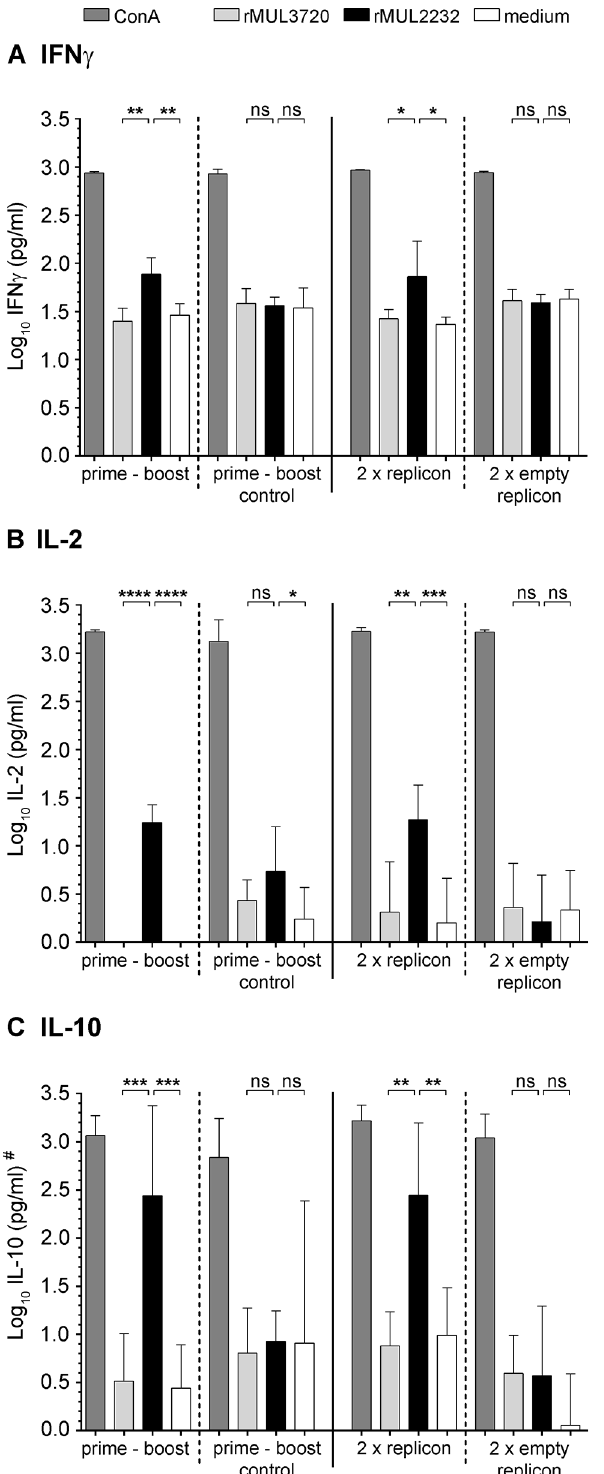
Fig 4. Analysis of cellular immune responses. Female BALB/c mice (n = 5) were immunized once with VSV * Δ G(MUL2232) (i.m.) and boosted with rMUL2232 (s.c., prime-boost) or were immunized with VSV * Δ G (i.m.) and boosted with rMUL2232 (s.c., prime-boost control). Alternatively, the animals were immunized twice with either VSV * Δ G(MUL2232) (2 x VRP) or the control vector VSV * Δ G (2 x empty VRP). Three weeks